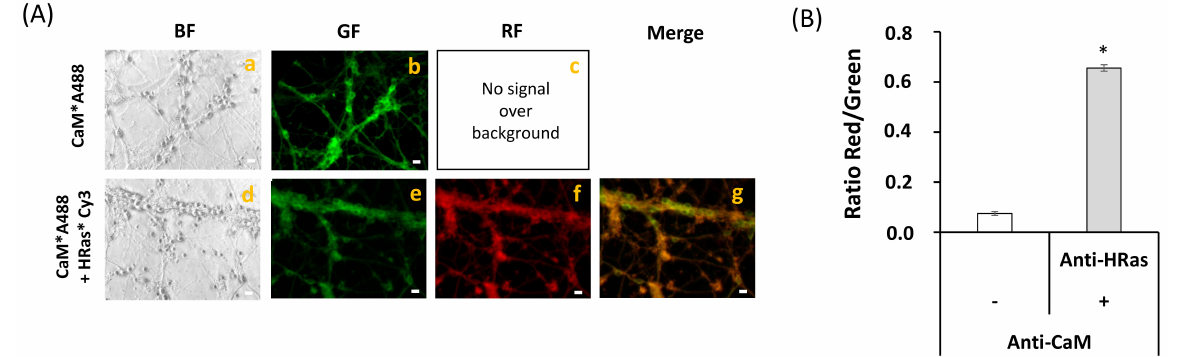
Figure 5. Extensive FRET between CaM and HRas. ( A ) Representative quantitative fluorescence microscopy images of CGN stained with the anti-CaM antibody (1716-1)/IgG-Alexa488 (CaM*A488, a–c) or with anti-CaM/IgG-Alexa488 and Anti-HRas antibody (sc32026)/IgG-Cy3 (CaM*A488/HRas*Cy3, d–g). Bright-field (BF), green fluorescence (GF), and red fluorescence (RF) images are shown for each of the selected fields, and the orange-yellow areas (Merge image) point out the higher intensity FRET regions (g). The exposure time for GF and RF images was 0.05 s. Scale bar inserted in fluorescence microscopy images = 10 µ m. ( B ) Ratio of red/green fluorescence intensity per pixel (RF/GF) obtained from the analysis of fluorescence intensity data of CGN somas stained with anti-CaM/IgG-Alexa488 only (CaM*A488) and double stained with anti-CaM*IgG-Alexa488/anti-HRas*IgG-Cy3 (CaM*A488/ HRas*Cy3). The results shown in ( B ) are the mean ± s.e. (*) p < 0.05 (i.e., statistically significant with respect to the control, CGN labeled with the Alexa488 FRET donor